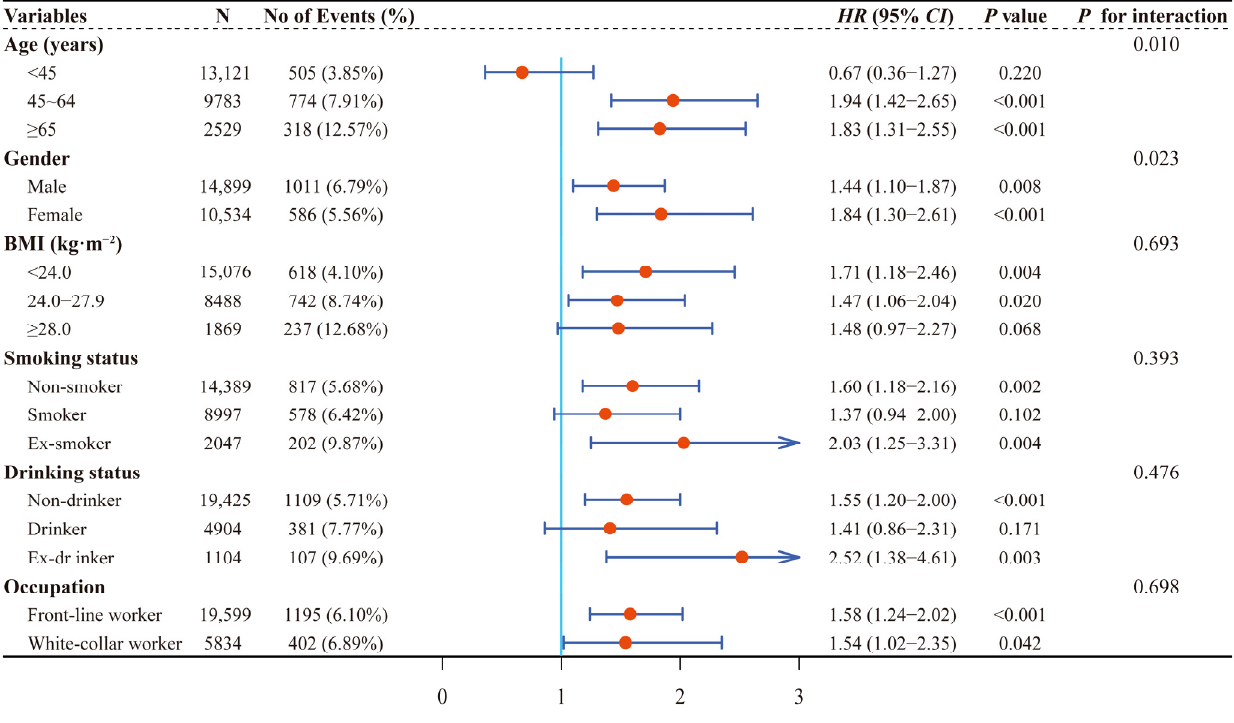
Figure 3. Stratified associations between CKD and new-onset HUA by age, gender, BMI, smoking status, drinking status, and occupation. CKD, chronic kidney disease; HUA, hyperuricemia; BMI, body mass index; HR, hazard ratio; CI, confidence interval.